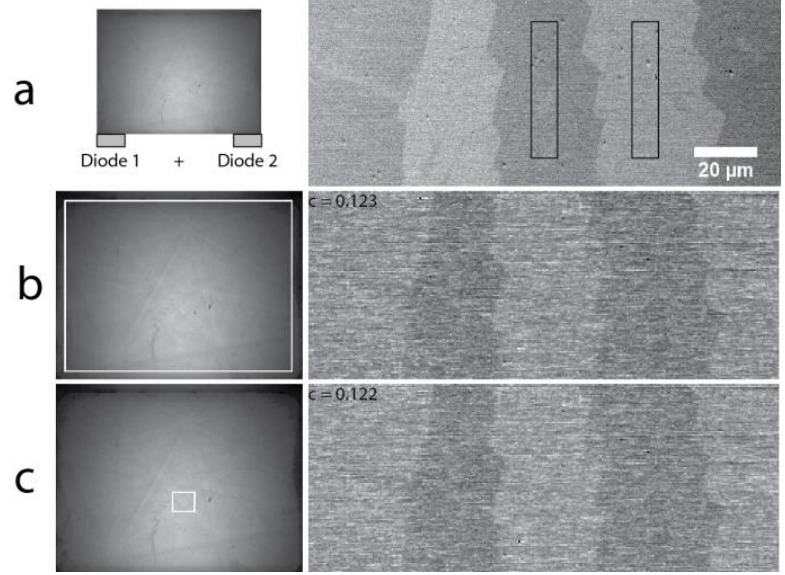
Figure 8. Magnetic domain images obtained from a non-oriented Fe-2.78%-Si electrical steel (right) and collection areas used to produce the images (left) with ( a ) the forward scatter detector (diode 1 + diode 2) attached to the EBSD camera screen; ( b ) the summed intensities over the full area of the EBSD camera screen and ( c ) the summed intensities from a small rectangle located around the maximum illumination area. The black rectangles in ( a ) define the areas used to calculate the contrast C displayed in ( b – c ). The scale bar displayed on the FSD image in ( a ) applies to the images in ( b – c ).